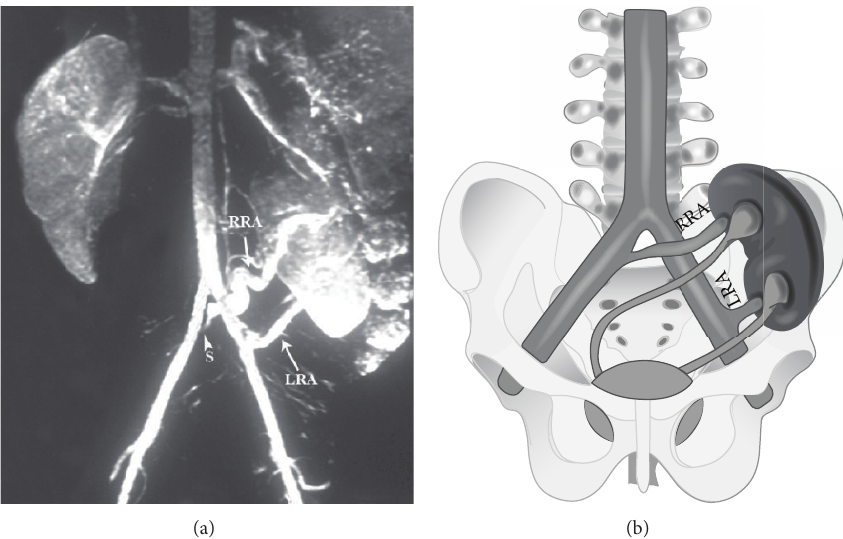
Figure 1: (a) The arterial phase of the 3D gadolinium-enhanced aortoiliac and renal magnetic resonance angiography of the patient. RRA and LRA (arrows) are pointing to the right and left main renal arteries, respectively, whereas S (arrow head) is marking the stenotic lesion closely located to the origin of the right main renal artery. (b) Schematic drawing of the renal and renal artery anatomy of the patient. Again, RRA and LRA are the right and left main renal arteries,